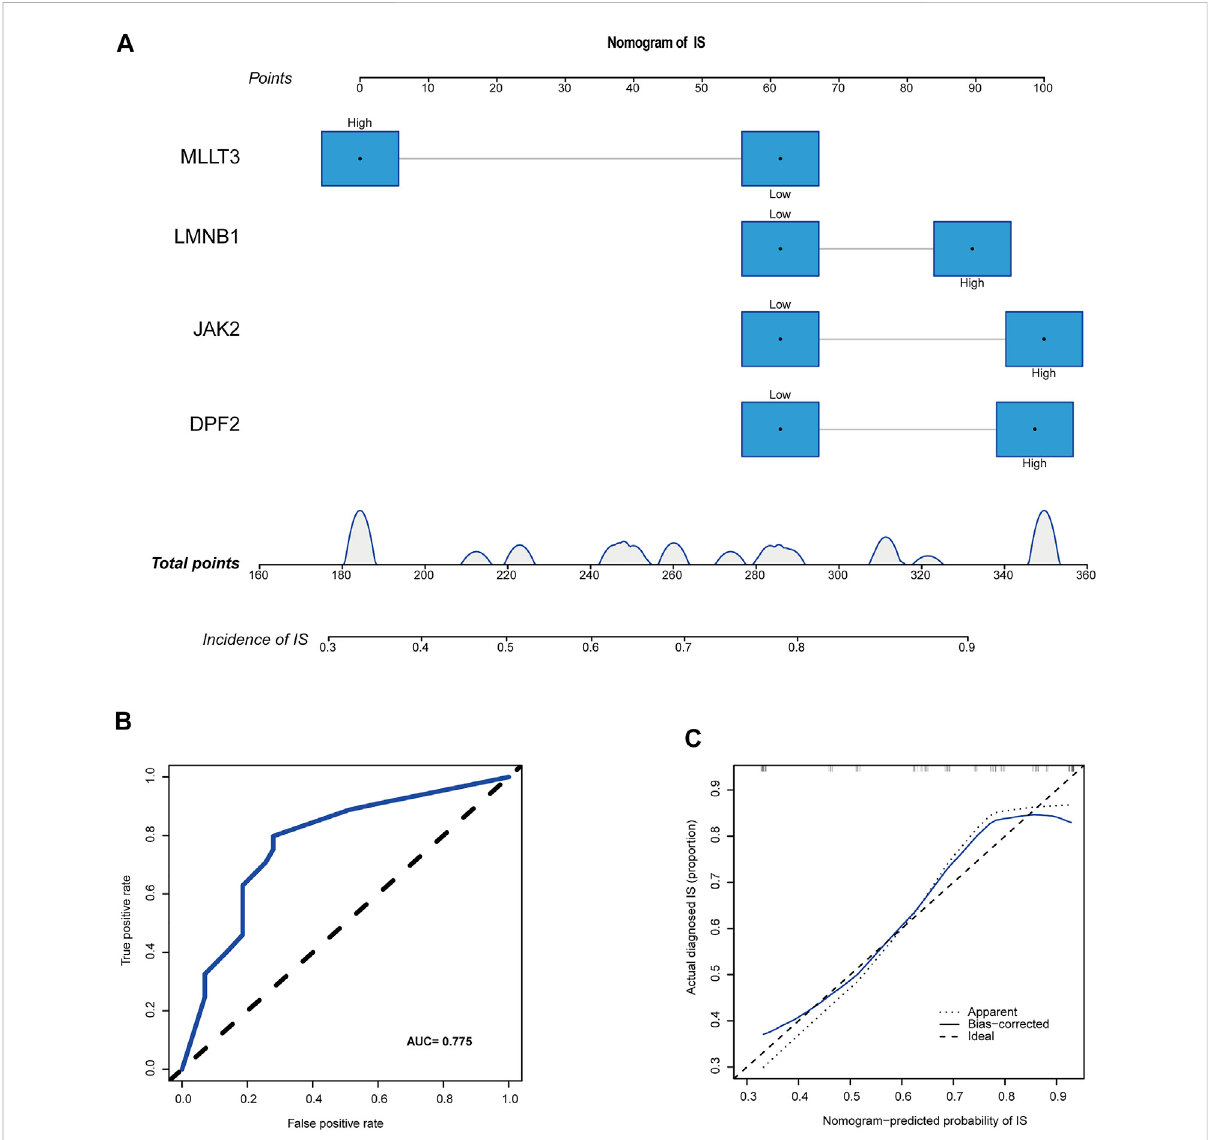
FIGURE 6 A novel nomogram for predicting IS. (A) CRs-related immune biomarkers predict the occurrence of IS. (B) ROC curve for nomogram. (C) The calibration curve for nomogram.